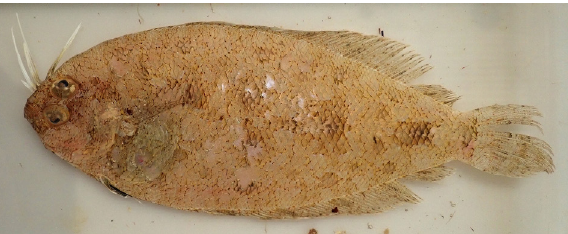
Fig. 10. – Arnoglossus imperialis Rafinesque, 1810, SMNS 27385, one male, 101.0 mm SL, southeast of Menorca, 133 m depth. Photograph of fresh specimens taken by Francesc Ordines. Ocular side.